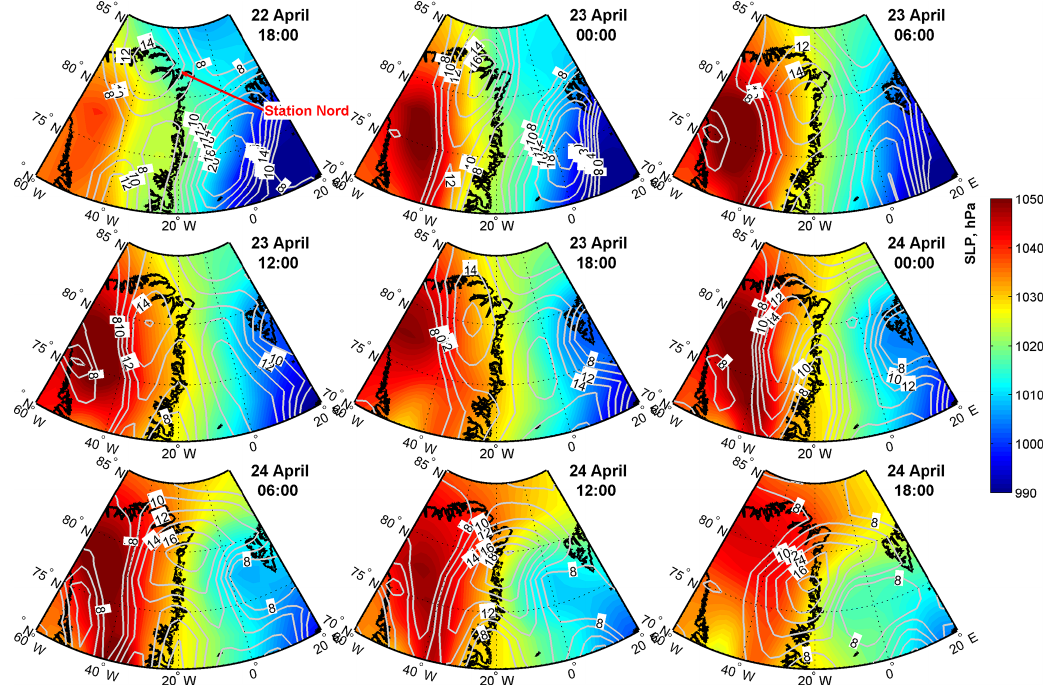
Figure 3. The evolution of the NCEP-derived sea level pressure (in colour, hPa) over northeast Greenland during the period 22–24 April 2015. The grey numbered contours indicate the surface wind speed equally spaced between 8 and 18ms − 1 at 2ms − 1 intervals.